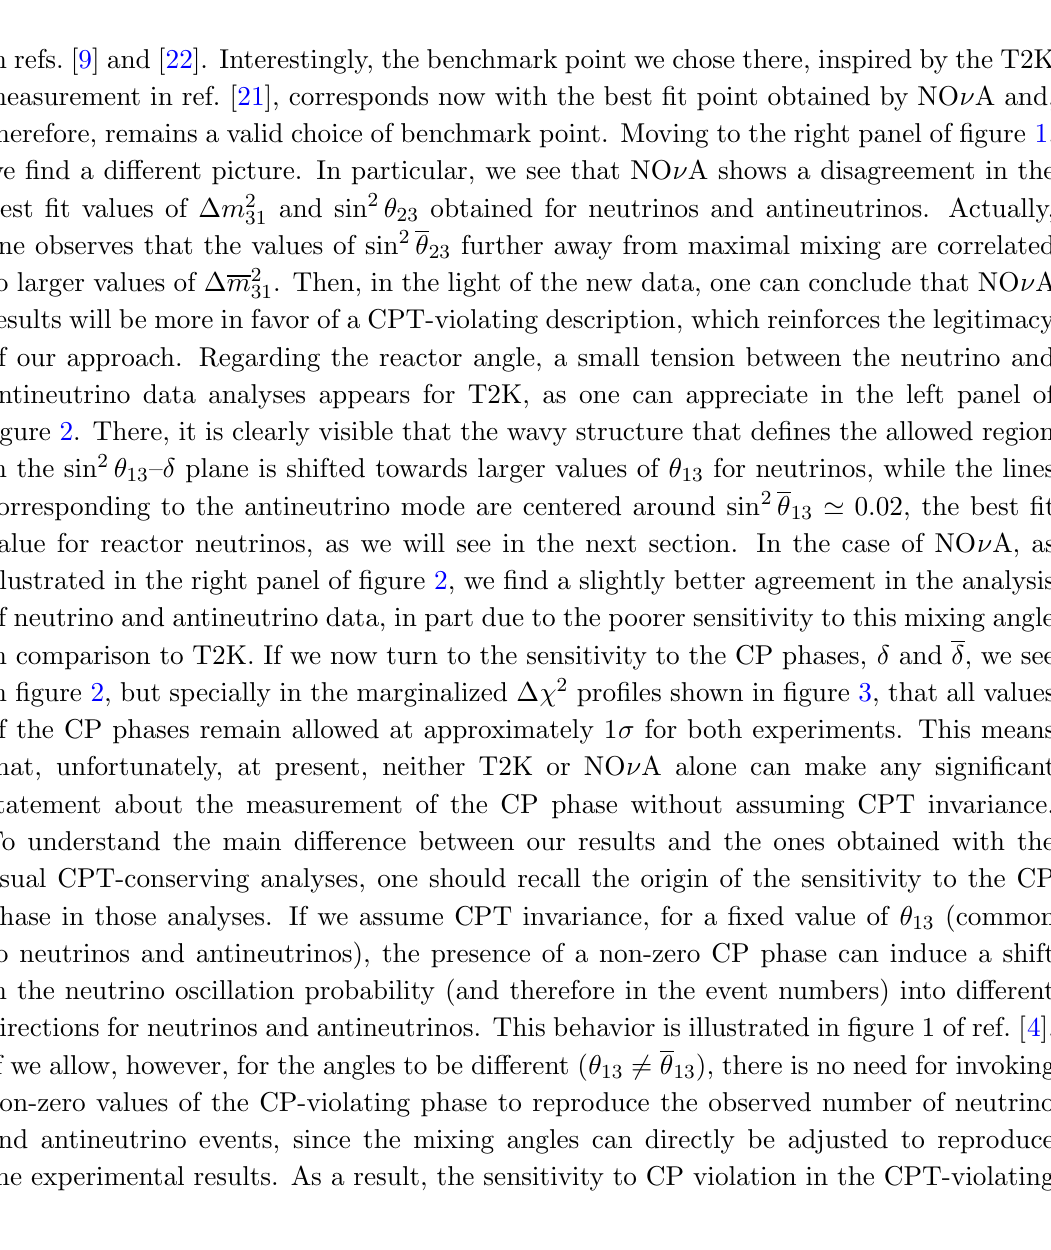
Figure 3 . (cid:1) (cid:31) 2 pro(cid:12)les obtained from the analysis of neutrino (blue) and antineutrino (red) data from T2K (solid) and NO (cid:23) A (dashed) for the CP phases (cid:14) (neutrinos) and (cid:14)